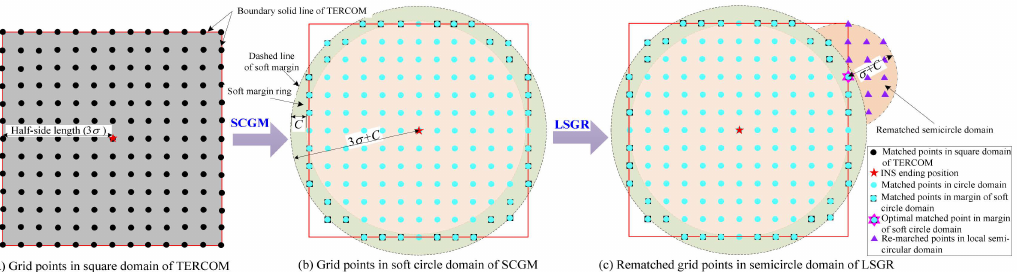
Figure 2. Diagram of the generation process of local semicircular re-matching grid points based on